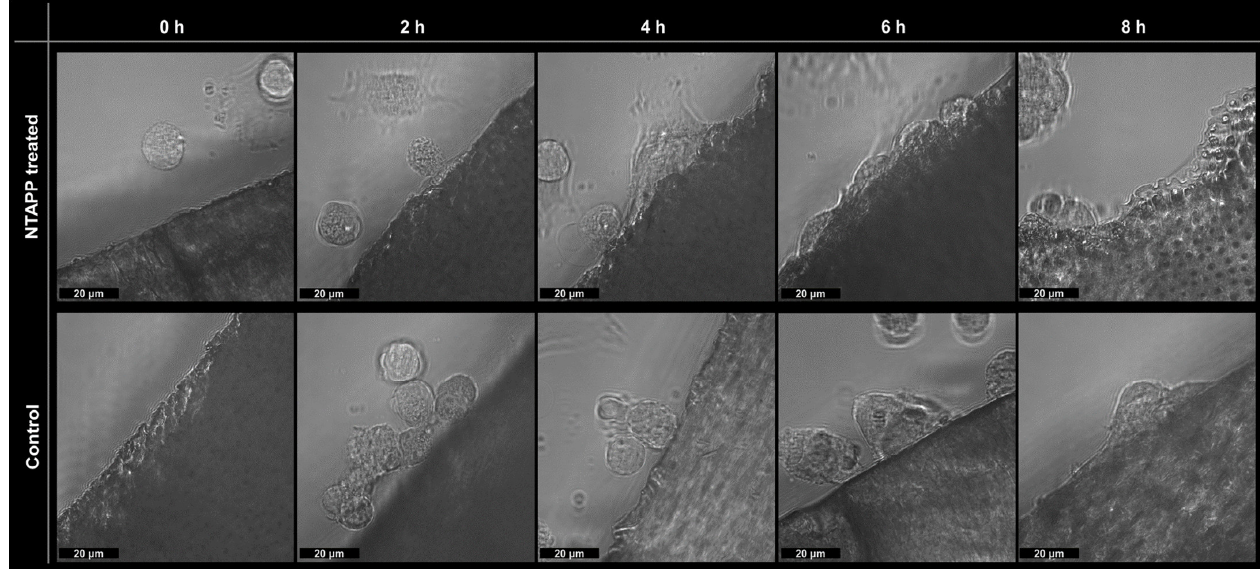
Figure 5. Live-cell imaging of hDPSCs attachment on root dentin. Holotomographic microscopy time series of NTAPP-treated (upper) and untreated controls (lower). Cells initiated attachment on NTAPP-treated dentin at 2 h, and on untreated controls at 4 to 6 h. hDPSCs on NTAPP-treated dentin had spread out over 4 to 6 h, and sprouted cellular processes into dentinal tubules at 8 h. Whereas, cells on untreated dentin were not spread until 6 to 8 h.